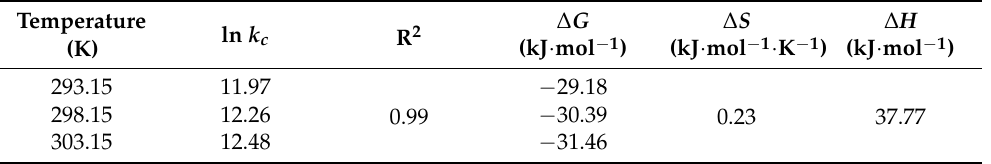
Table 4. Thermodynamic parameters of the phosphate adsorption onto Mn 2+ /Zn 2+ /Fe 3+ /Mg-Al- LDH